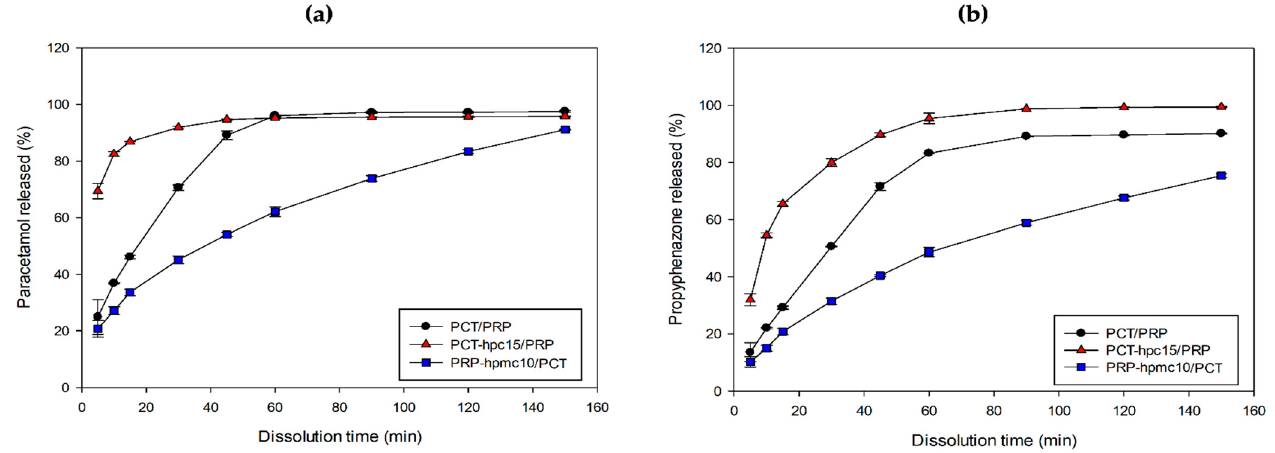
Figure 11. In vitro release profiles of ( a ) PCT and ( b ) PRP from the optimal CSD/neat combination tablets.